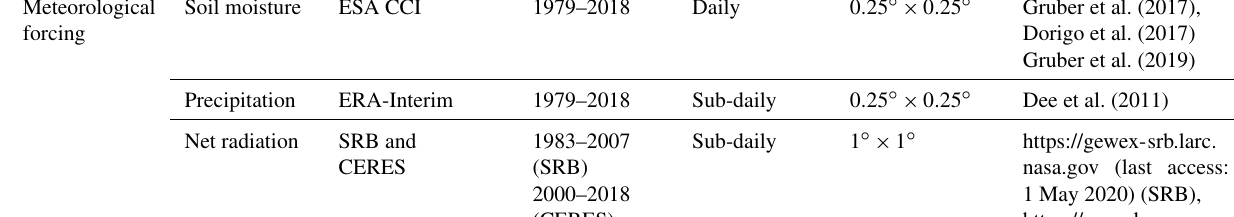
Table 1. Overview of employed observation-based datasets.